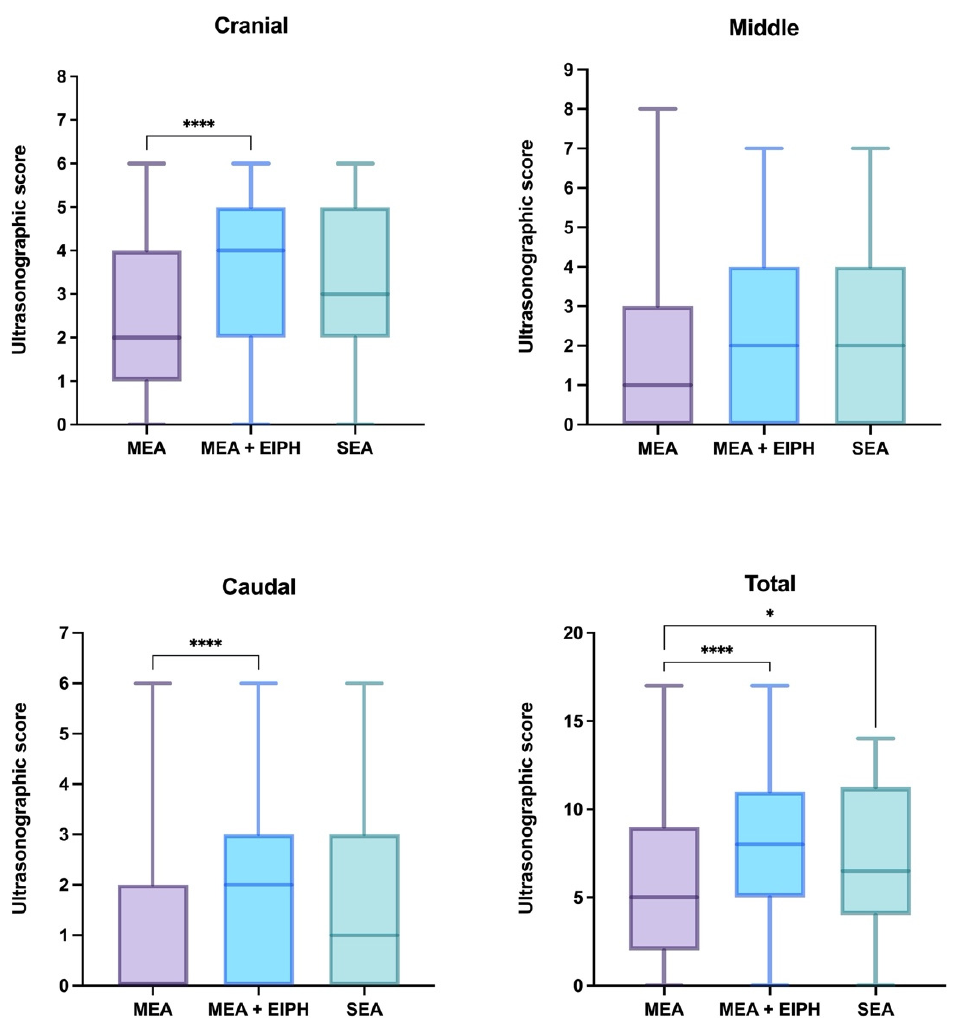
Figure 1. Box plot showing ultrasonographic scores of the cranial, middle and caudal lung fields, and the total ultrasonographic scores in the SEA, MEA and MEA + EIPH groups. The statistical significance is shown as * ( p < 0.05) and **** ( p < 0.0001).